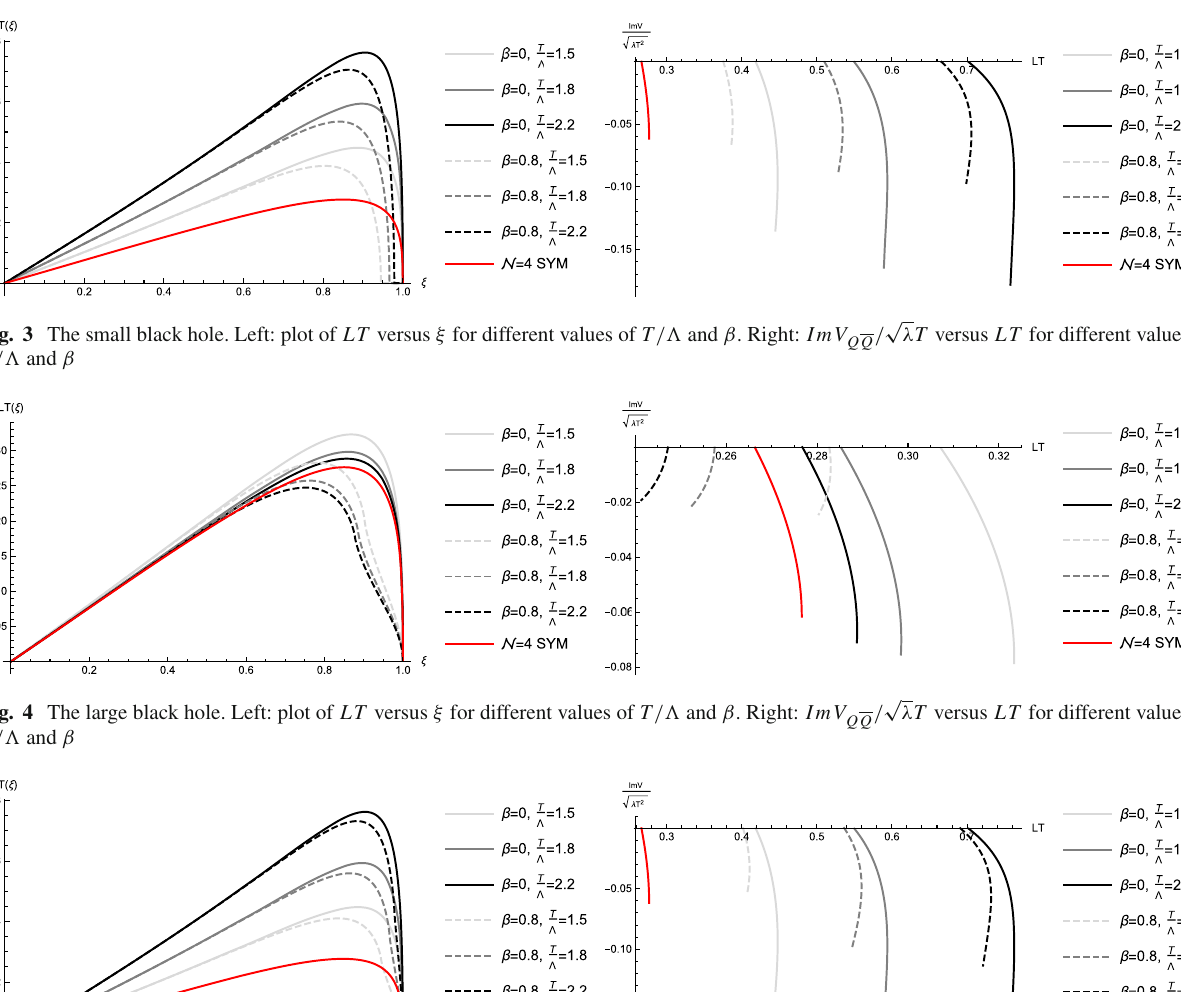
Fig. 5 The small black hole. Left: plot of LT versus ξ for different values of T /(cid:2) and β . Right: ImV T /(cid:2) and